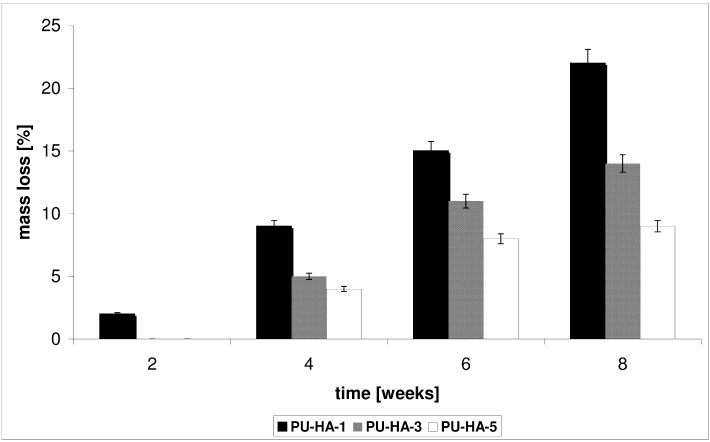
Figure 9. Mass loss of the PU-HA-1, PU-HA-3 and PU-HA-5 composites after the biodegradation process.